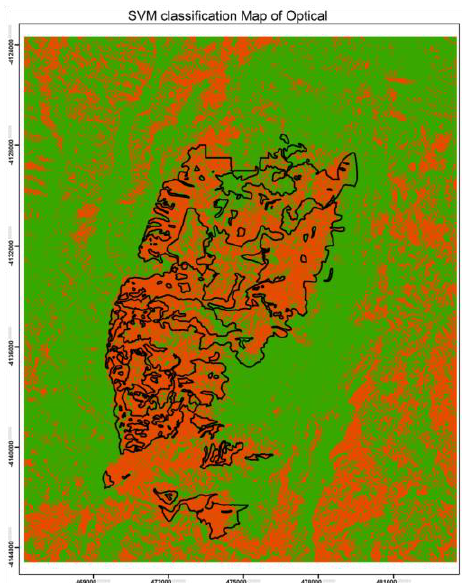
Figure 7. Classified map of Landsat-8 optical imagery of study area. Red colour representing burnt areas and green representing unburnt